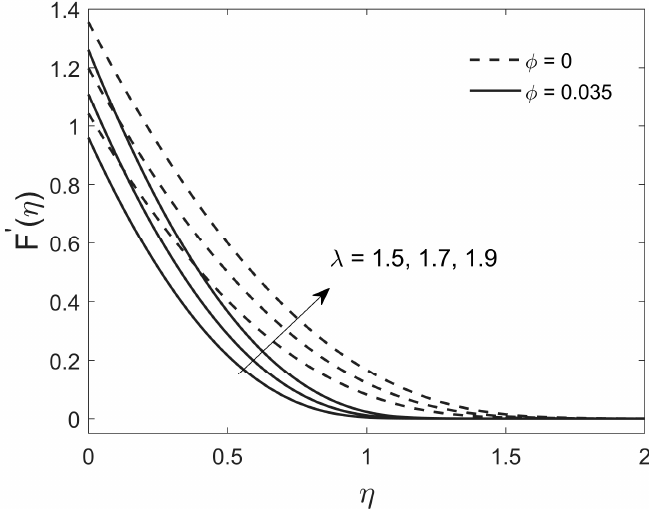
Figure 8. Effect of stretching/shrinking on the velocity profile.